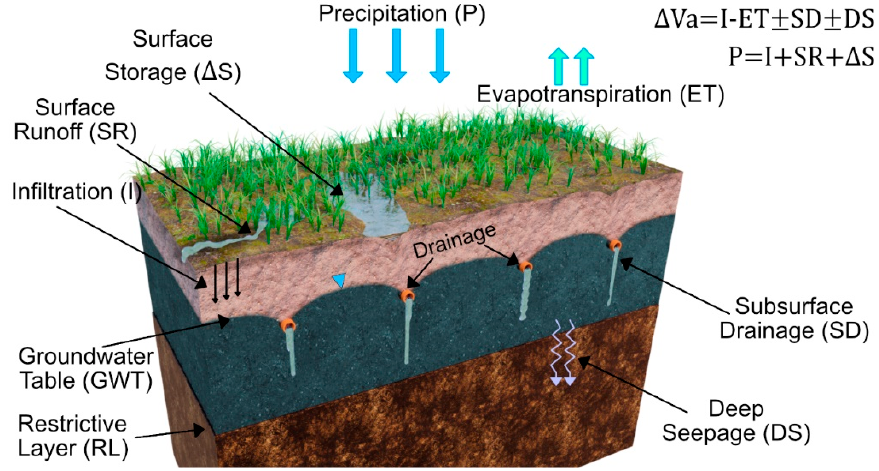
Figure 2. DRAINMOD calculation schema.